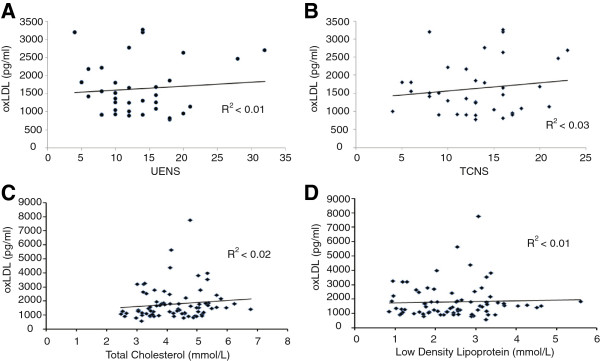
Linear relationships were sought between oxLDL and clinical scores of peripheral neuropathy as well as for laboratory measurements for lipids. For all subjects with DPN, there was no significant relationship between plasma oxLDL levels and the UENS (A) or TCSS (B). For all subjects with DM, there was no significant association between plasma oxLDL levels and total cholesterol (C) or low density lipoprotein levels (D). Linear regression was performed, with R2 values presented for each association sought.